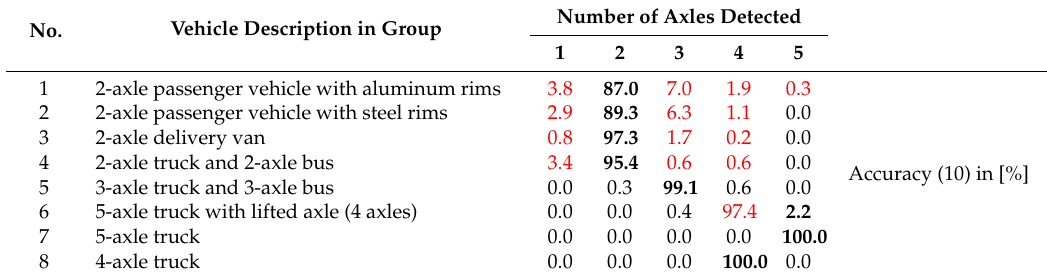
Table 3. Vehicle axle detection accuracy (10) using an algorithm-core verified for 4000 vehicles. Number of Axles No. Vehicle Description in Group